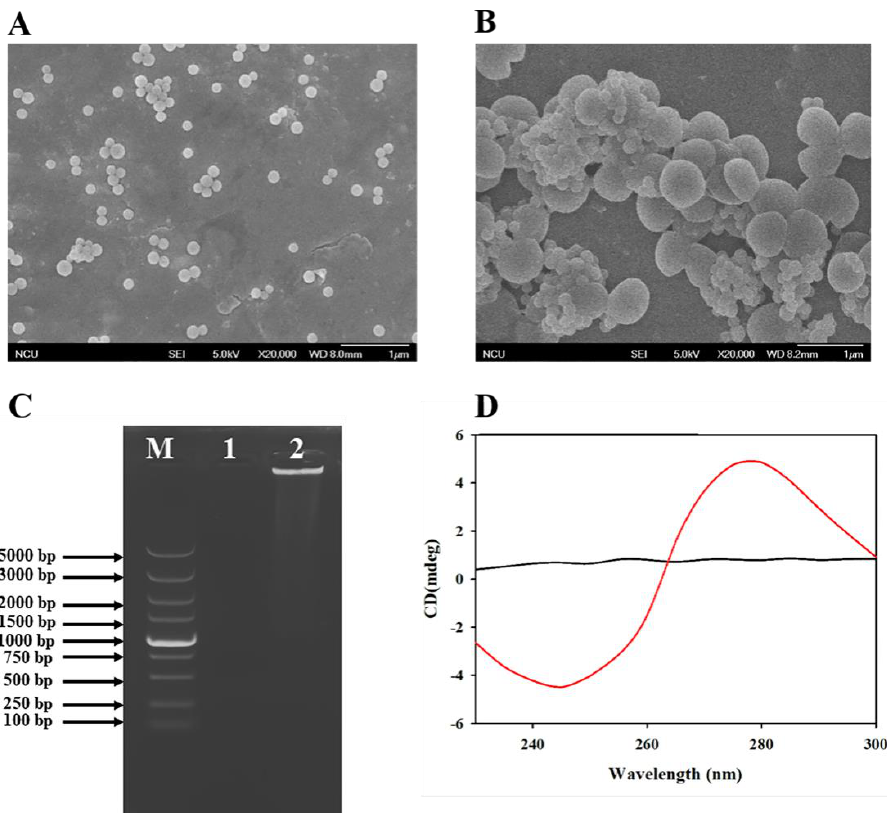
Figure 2. The SEM images of ( A ) Van-MNPs, ( B ) S. aureus captured by Van-MNPs, and ( C ) 1.5% agarose gel electrophoresis images of the RCA products. Lane M: DNA marker, Lane 1: the padlock without primer, Lane 2: padlock and primer. ( D ) Circular dichroism spectroscopy for the